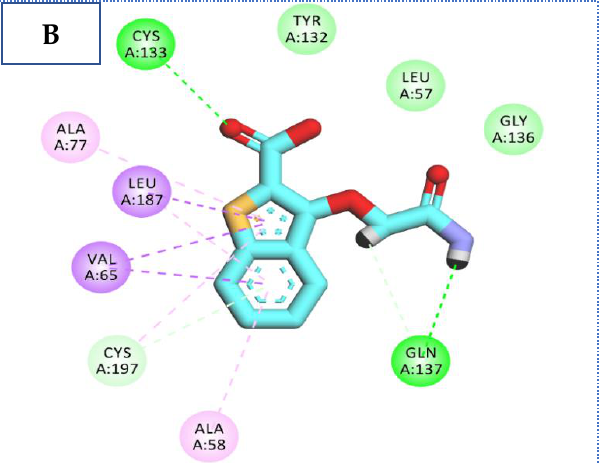
Figure 6. ( A ) The 3D and ( B ) 2D binding of 27 in the active site of BMP-2-inducible kinase (hydrogen bonds = green dashed lines, pi-pi interactions = purple dashed lines, and pi-alkyl interactions = light pink dashed lines).